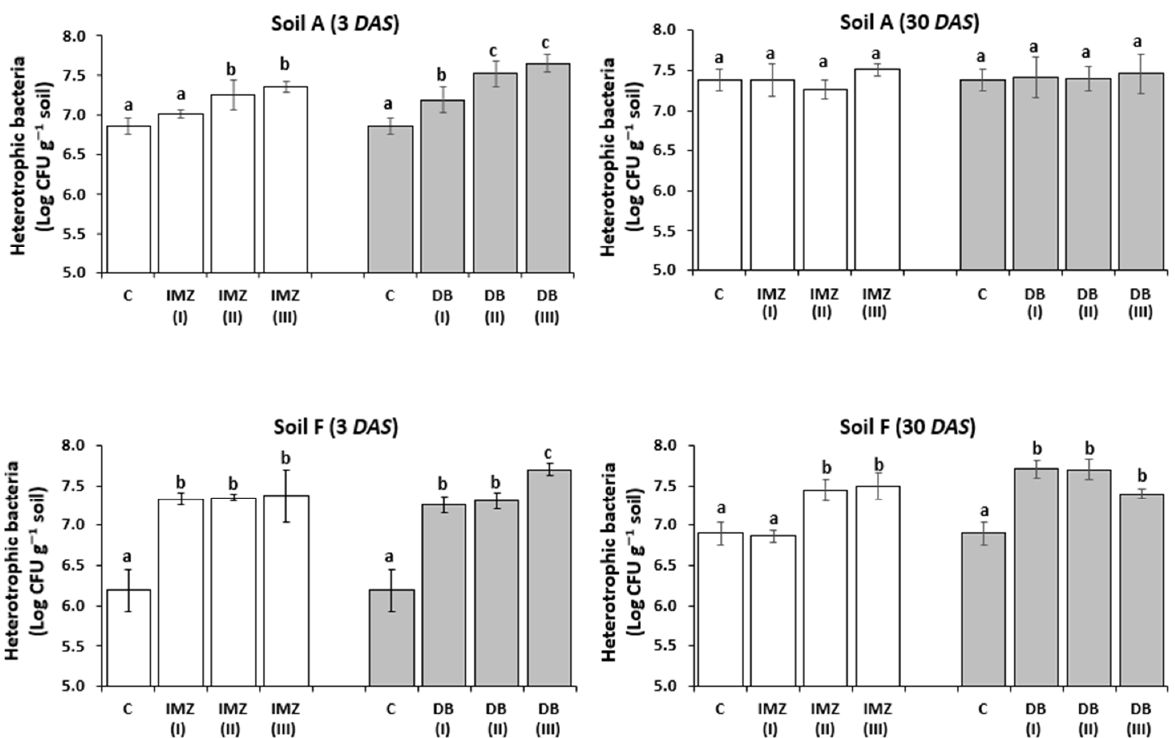
Figure 1. Influence of different concentrations of imazamox (IMZ) and 2,4-DB (DB) on the number of soil total culturable heterotrophic bacteria (mean values ± SE) at 3 and 30 days after herbicide spiking ( DAS ). IMZ(I), (II) and (III) refer to 3, 15, 150 µg IMZ g − 1 soil, respectively. DB(I), (II) and (III) refer to 100, 500, 5000 µg DB g − 1 soil, respectively. C, control (untreated) soil. For each soil and herbicide, different letters on top of bars indicate statistically significant differences (Bonferroni cor- rected p -value < 0.05).